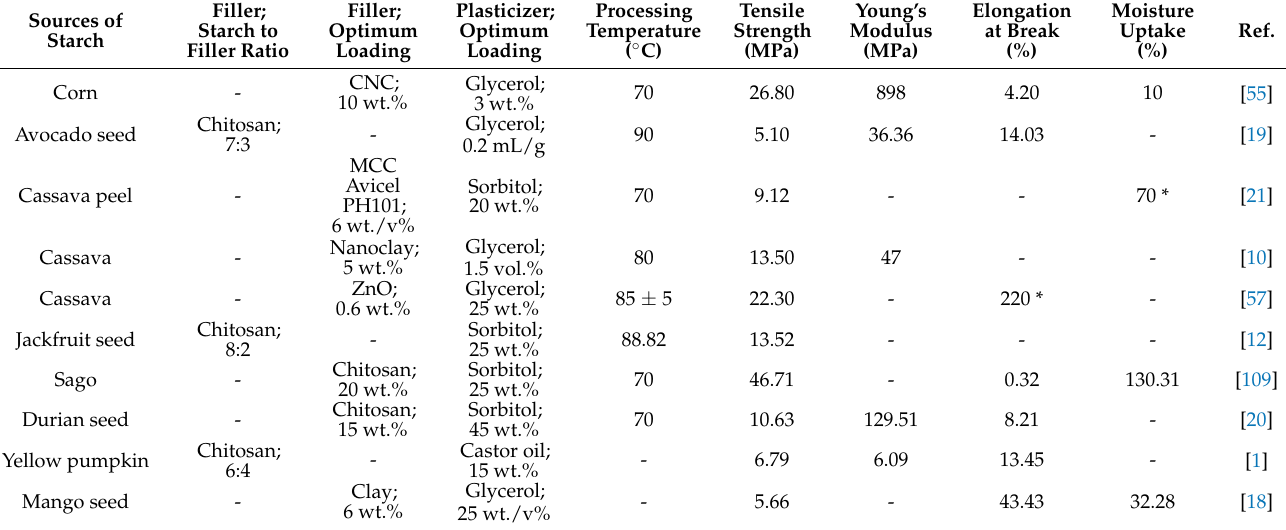
Table 3. Optimum reaction conditions for fabrication of starch-based bioplastics using solvent-casting